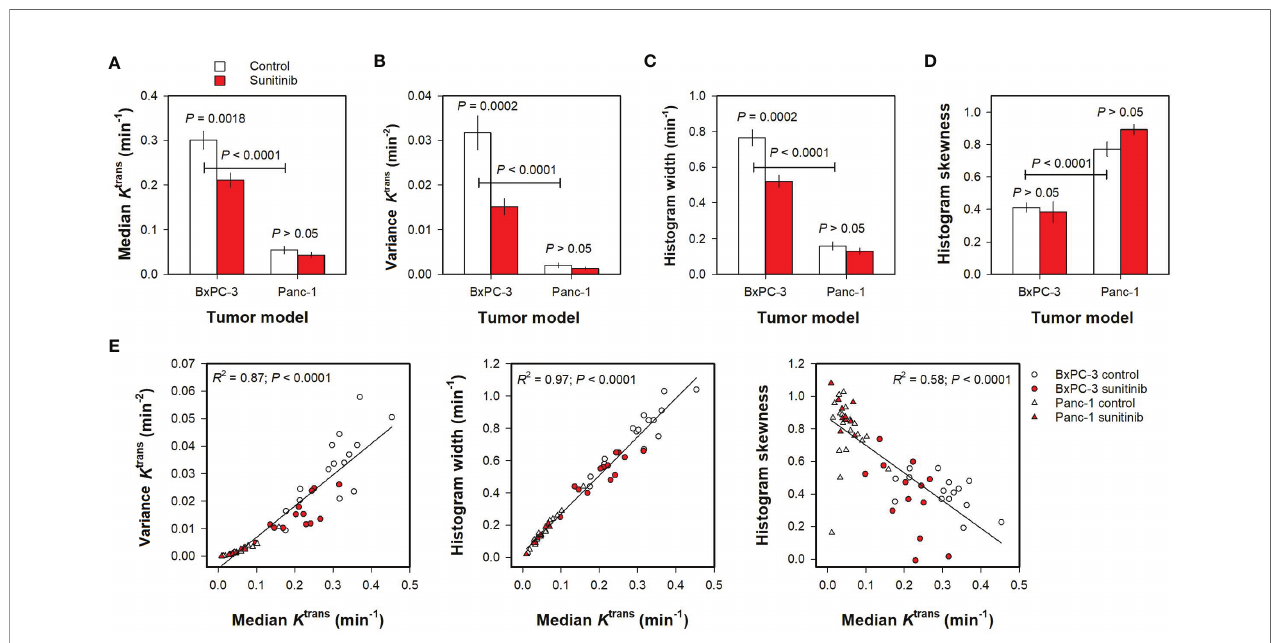
FIGURE 3 | (A – D) Median K trans , variance K trans , K trans histogram width, and K trans histogram skewness in untreated and sunitinib-treated BxPC-3 tumors and in untreated and sunitinib-treated Panc-1 tumors. Columns and bars, mean ± SEM of 10-20 tumors. (E) Variance K trans , K trans histogram width, and K trans histogram skewness versus median K trans in untreated and sunitinib BxPC-3 and in untreated and sunitinib-treated Panc-1 tumors. Points, individual tumors; Curves, linear regression